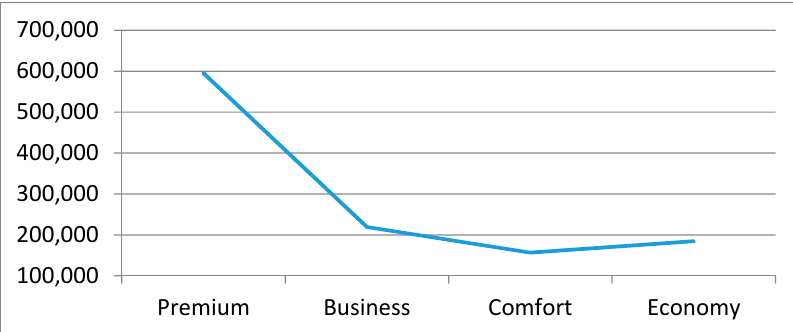
Figure 9. Impact relative (per user) vs. building comfort level.